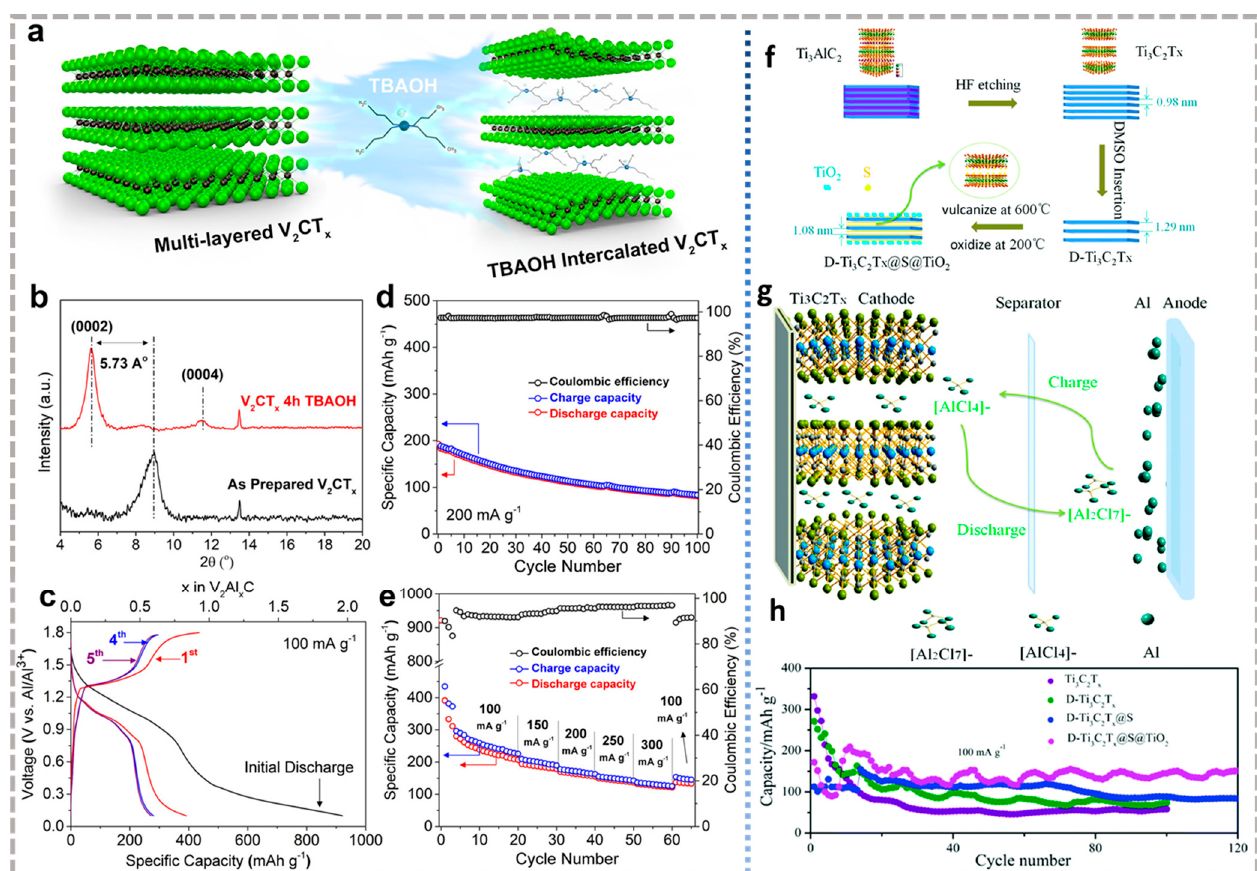
Figure 8. ( a ) Schematic diagram of TBAOH intercalated ML-V 2 CT x for interlayer expansion; ( b )